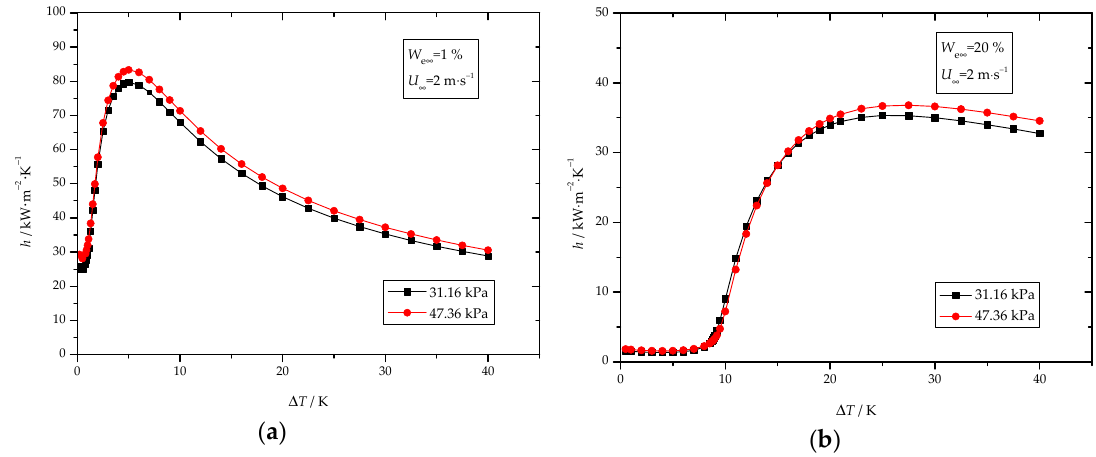
ffi cients on di ff erent pressures at ( a ) W = 1% e ∞